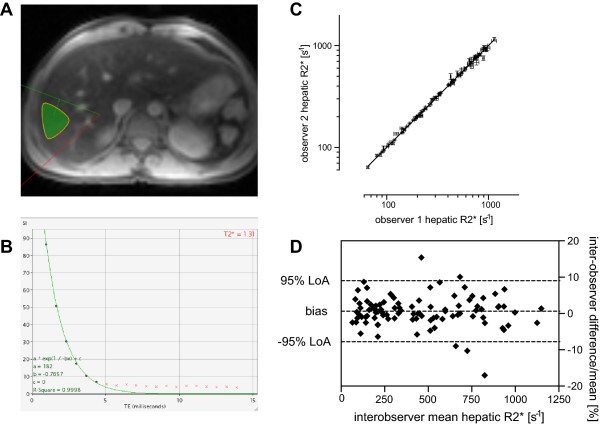
T2* method and inter-observer reproducibility. (A) A transverse slice of the liver where an example of the region of interest (ROI) is seen in green within the mid/lateral area free of large vessels. (B) T2* estimation using the truncation method in exponential curve fitting: crosses represent truncated data points whereby only the first 5 points contribute to the decay curve model. (C) The inter-observer reproducibility and agreement for R2* between observer 1 and 2 (both in triplicate, error bars show SEM, 96 scans) with line of identity. Coefficient of variation 5.79%. (D) Bland-Altman analysis of inter-observer liver R2* percentage differences plotted against the mean R2* of the two observers. The bias as the mean of all differences was 0.61 ± 4.29% (SD). The 95% limits of agreement (LoA) were between -7.79 and 9.02%.